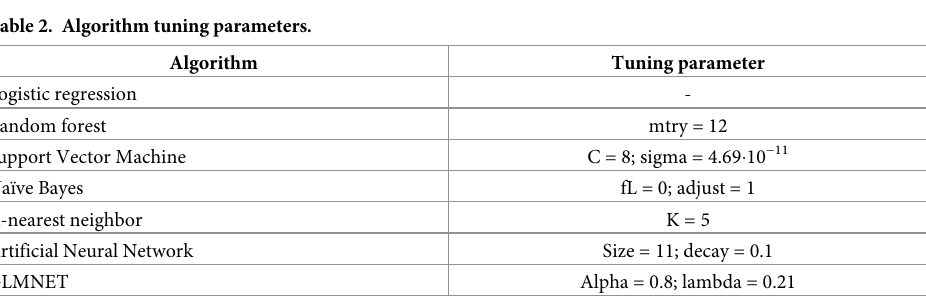
Table 2. Algorithm tuning parameters. Algorithm Tuning parameter Logistic